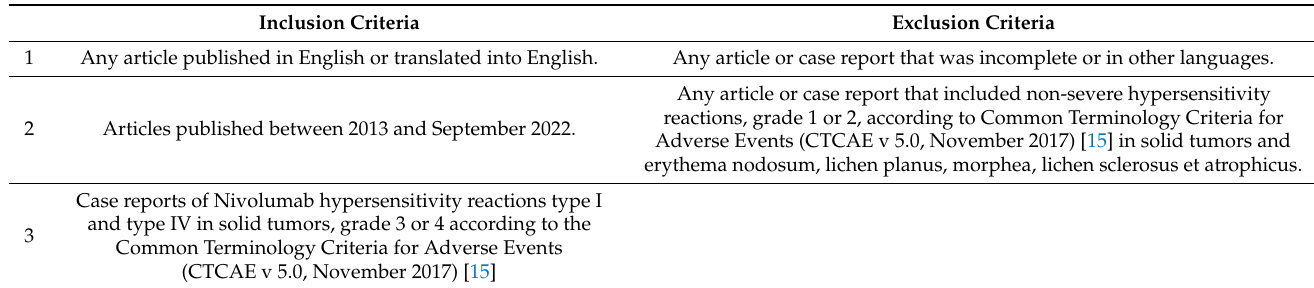
Table 1. Inclusion and exclusion